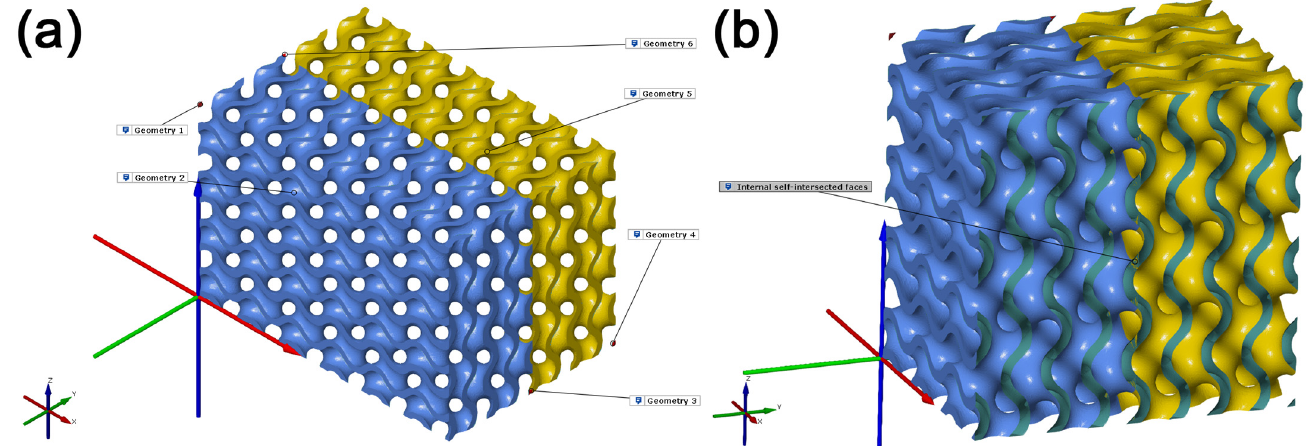
Figure 5. Tessellated cellular structure model composed of six geometric models. ( a ) illustration of separate models making up a single mesh; ( b ) illustration of duplicate areas in the region where the geometric models merge.